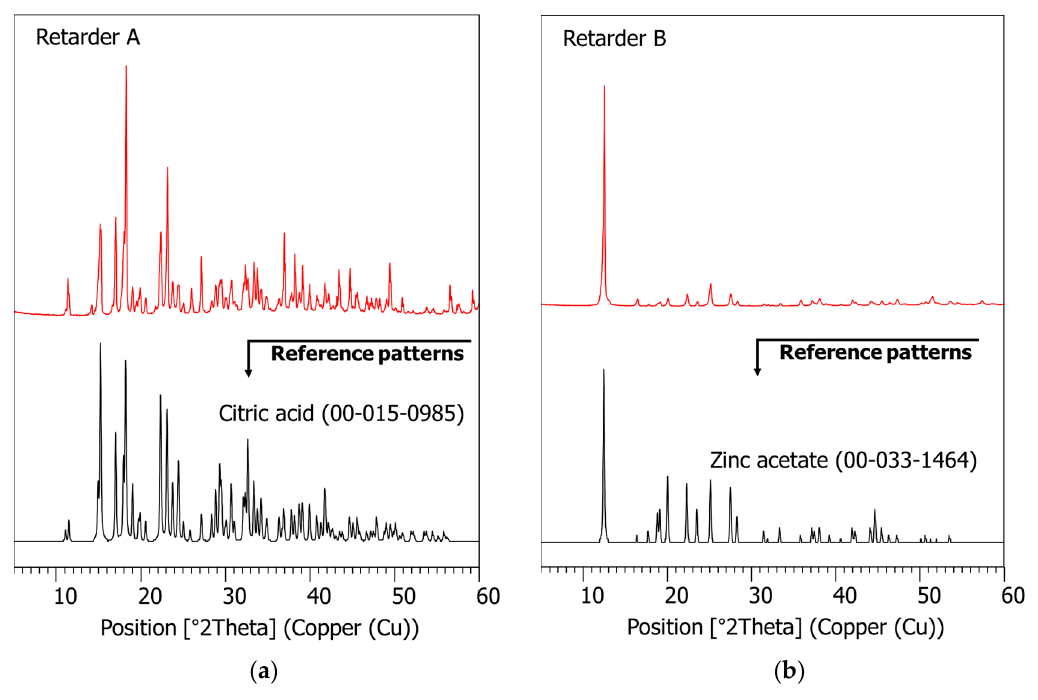
Figure 3. The XRD patterns of the set retarders: ( a ) citric acid; ( b ) zinc acetate. Table 3. The XRF and elemental analysis results of the polymer powder (unit: wt.%). Oxide Composition (wt.%)